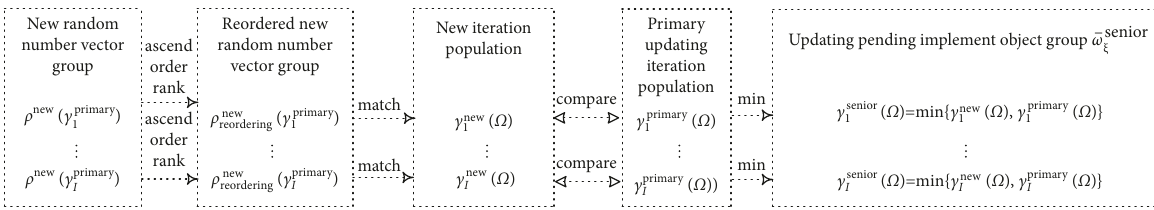
Figure 9: Senior updating iteration population.